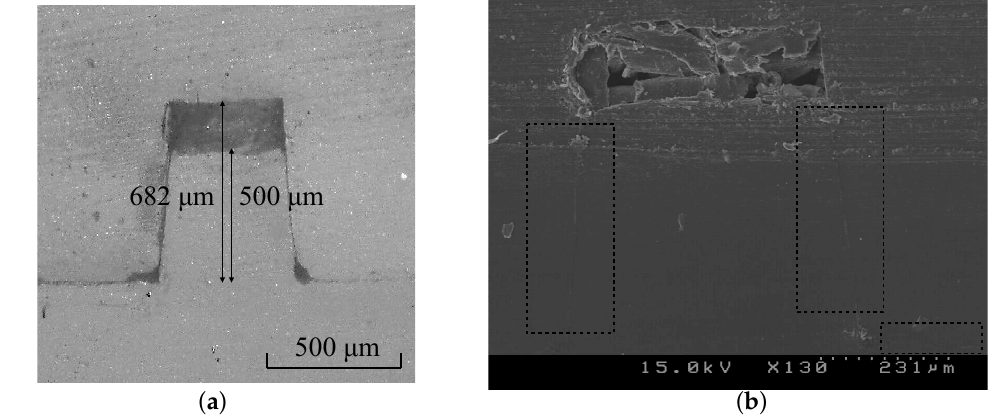
Figure 7. Cross-sectional micrographs of the microchannel observed by ( a ) optical microscope; and ( b ) scanning electron microscope (SEM). The dotted boxes in the SEM micrograph indicate the contact region. The bonding temperature and bonding pressure are 95 ◦ C and 2 MPa, respectively.